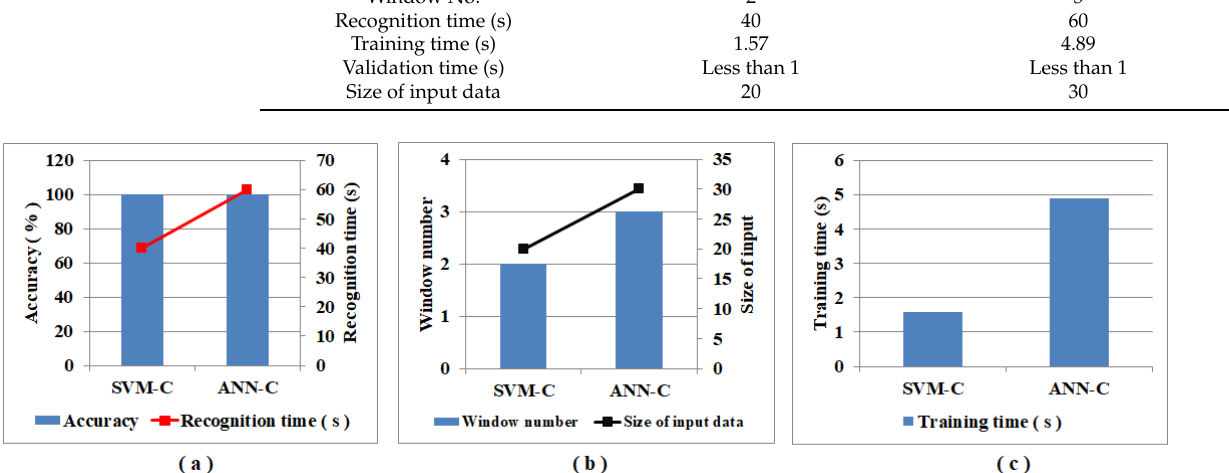
Figure 3. Graphical representation of a comparison of performance metrics ( a ) accuracy, recognition time, ( b ) window number, size of input data, and ( c ) training time of classification models SVM-C and